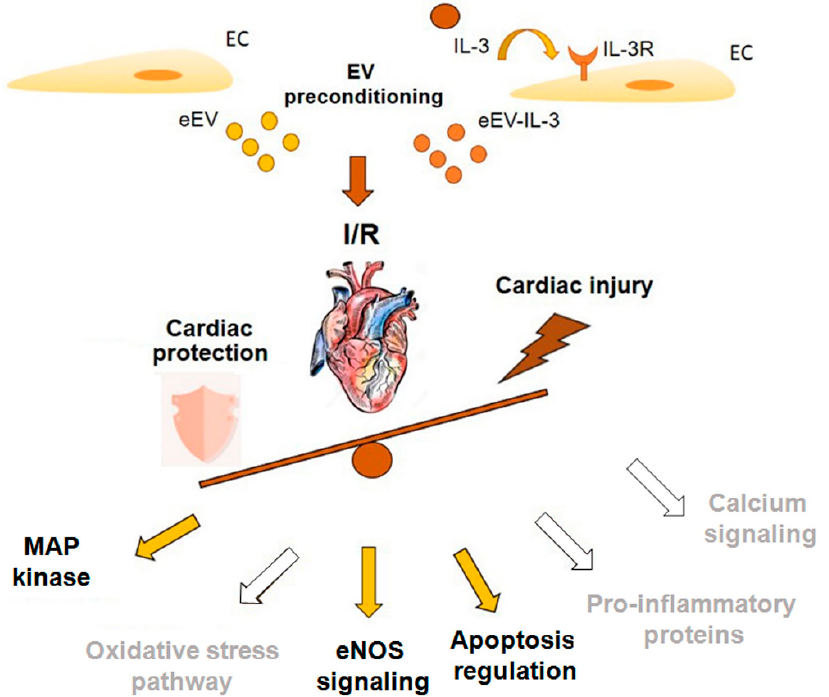
Figure 7. Schematic representation of eEV and eEV-IL-3 action on I/R injury. eEV and eEV-IL-3 were administered ex-vivo prior to I/R injury. A selective activation of specific signaling components likely mediates eEV cardioprotection. Different molecules can drive preconditioning protective signaling upon eEV treatment. eNOS, ERK1/2, and the anti-apoptotic protein Bcl-2 were validated. Other predicted but not validated pathways include PI3-kinase/Akt and oxidative stress (indicated by the gray font–white arrows). In response to eEV-IL-3, the transfer of inflammatory, apoptosis mediators and caveolin 1 likely change the balance and may trigger death signaling ex vivo. Table S1: Proteins commonly expressed by eEV and eEV-IL-3, Table S2: Mass spectrometry data of IL-8 pathway comparing eEV and eEV-IL-3, Table S3: Mass spectrometry data of NF-kB pathway comparing eEV and eEV-IL-3. Table S4: Mass spectrometry data of inflammatory related proteins identified in eEV and eEV-IL-3 compared with proteins identified in EV released by HUVEC in response to TNF- α (EV-TNF- α ).